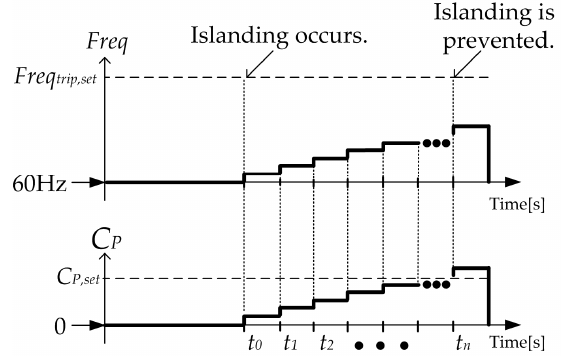
Figure 5. Operational waveform of the proposed anti-islanding method.